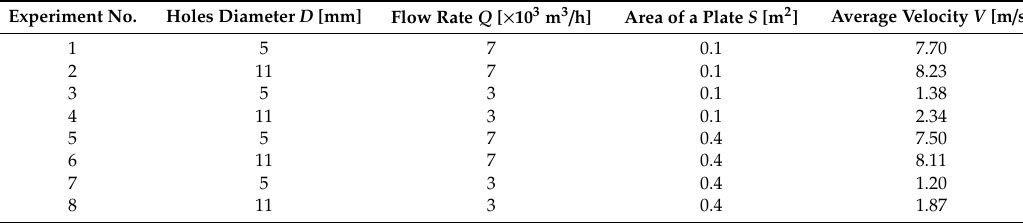
Table 4. The matrix of planning a three-factor